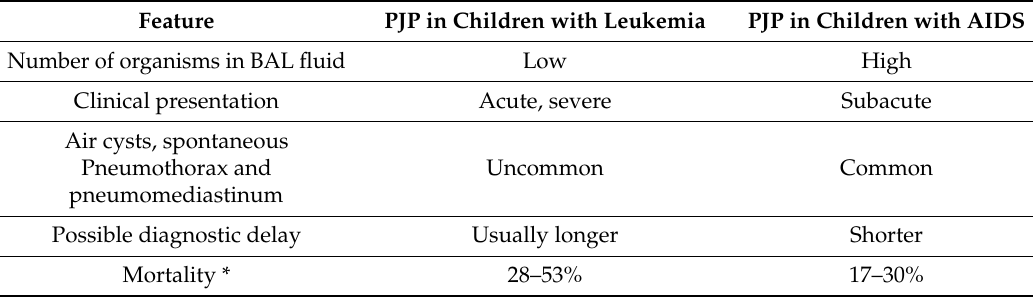
* From Table 2 of reference [56]. BAL: bronchoalveolar